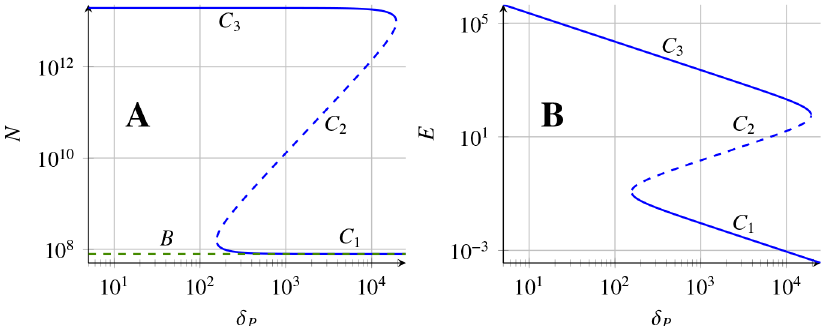
Fig 12. Different tumour morphologies for LLC depending on VEGF degradation rate. Stability diagram for steady states of Eq (23) depending on the parameter δ P , all other parameter values are given in Table 3. The stability of existing steady states in indicated by solid lines, while instability by dashed. Colours indicate the steady states B (green) C i (blue). Additionally, E = 0 for state B , therefore it is not indicated on the right- hand side